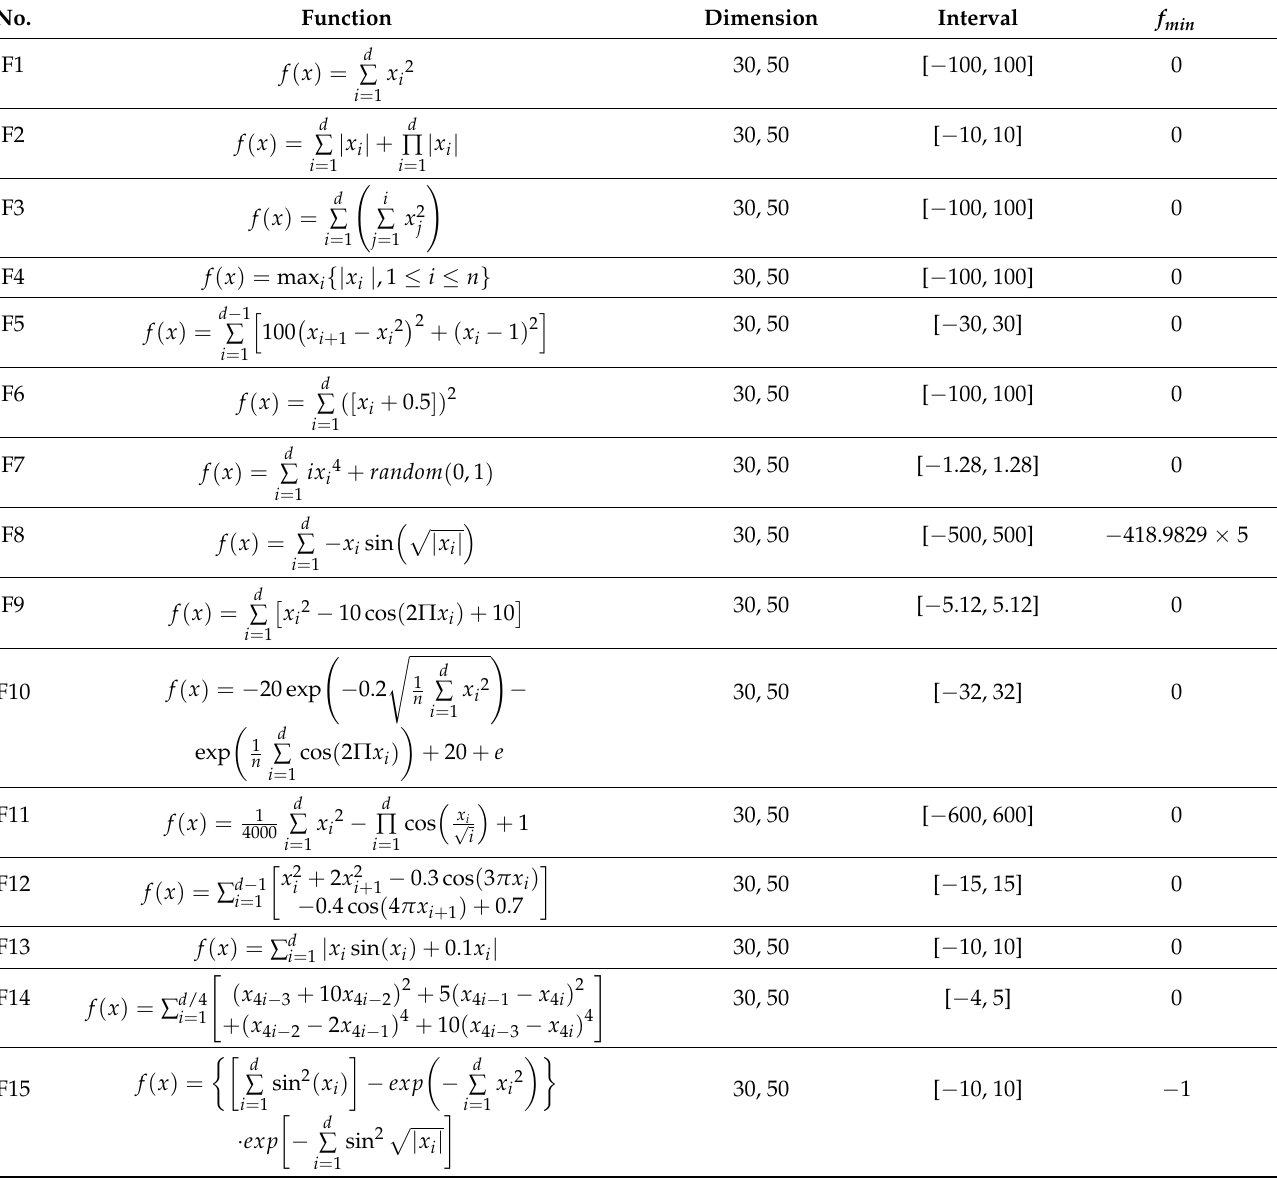
Table 1. Detailed description of the test functions